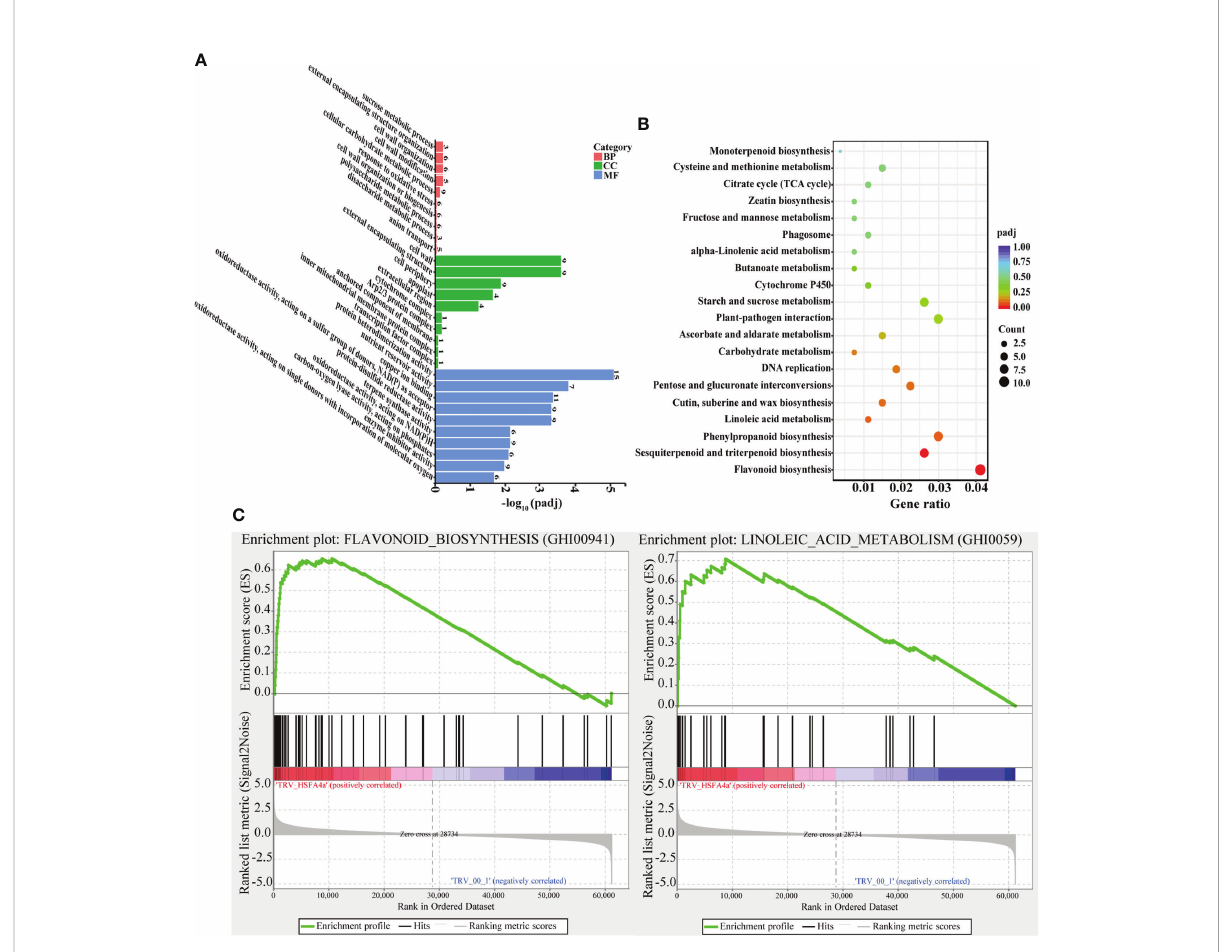
FIGURE 6 GO, KEGG, and GSEA metabolic pathway enrichment for DEGs in pTRV2:: 00 and pTRV2:: GhHSFA4a cotton. (A) GO terms. (B) KEGG terms. (C) GSEA analysis shows that two plant resistance-related gene sets are signi fi cantly activated in GhHSFA4a -silenced cotton compared with those in the control group. BP, biological process; CC, cellular component; MF, molecular